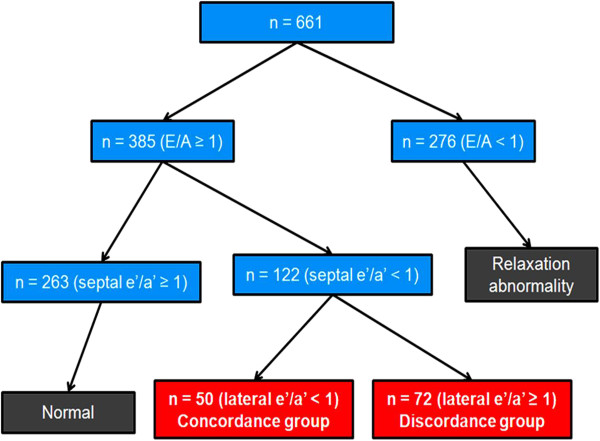
Schematic figures showing enrollment flow of study subjects.